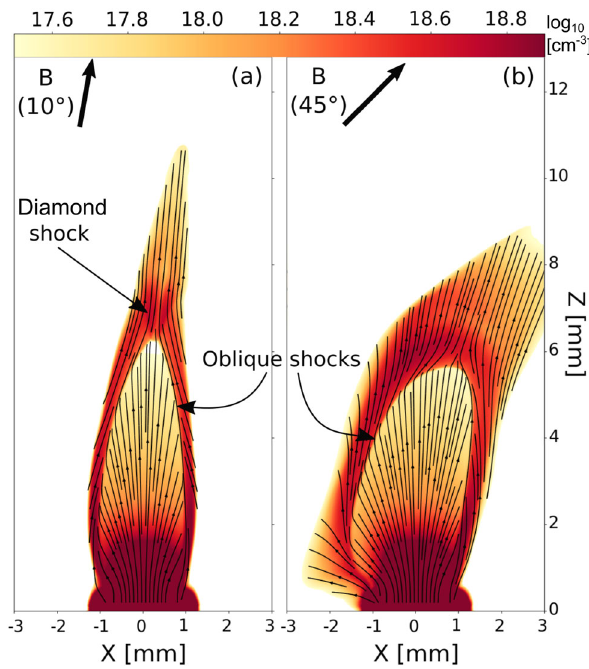
Fig. 6 Simulation insights in the cavity formation disruption. 2D slices of the decimal logarithm of the electron density (in the xz plane) from 3D MHD GORGON simulations for a α = 10 degrees and b α = 45 degrees. Also shown are some velocity streamlines (black lines) displaying the differences in fl ow collimation as the angle is increased. Both images correspond to a time of 10 ns after the start of plasma expansion. The target material is made of Carbon — see ” Methods ” section to get insights about the simulations and the reason for the difference with the experimental target